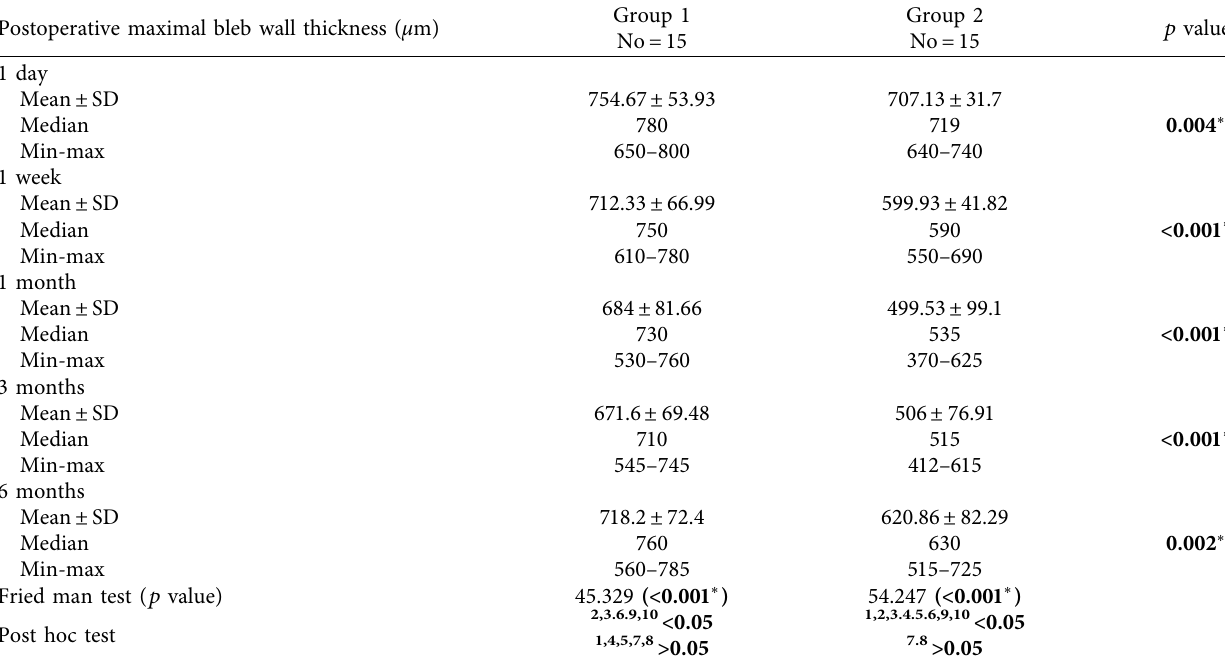
Table 4: Maximal bleb wall thickness of the studied